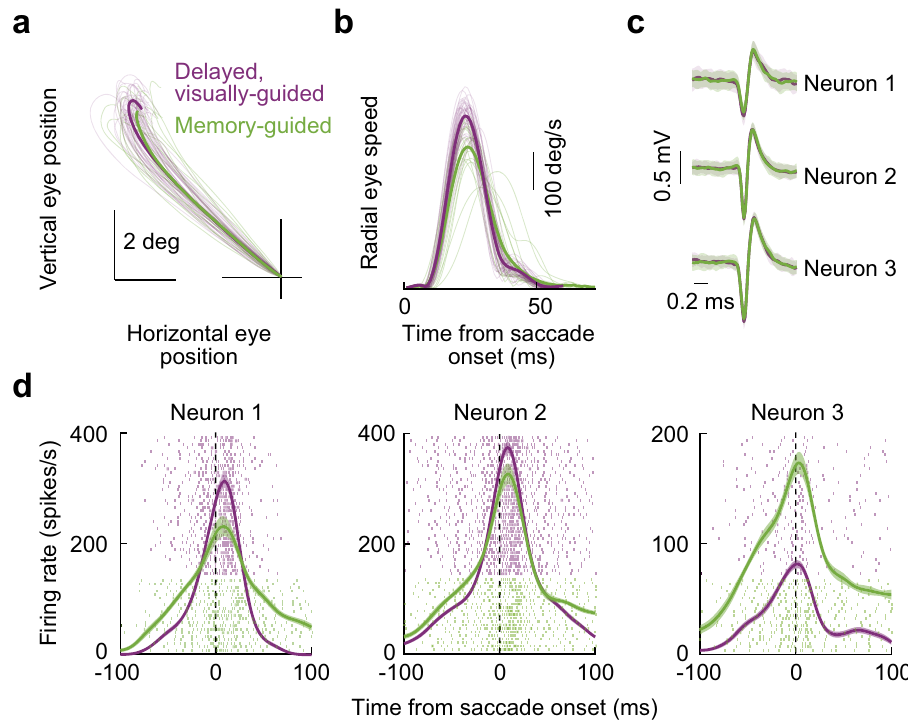
Fig. 6 Superior colliculus motor burst strength is dissociated from saccade kinematics even for vector-matched movements. a Example saccade trajectories from one session of the vector-matched experiments. Thin lines show individual movements, and thick lines show averages across trials. Purple denotes delayed, visually-guided saccades, and green denotes memory-guided saccades. The vectors of the two types of saccades were matched ( “ Methods ” ). b Memory-guided saccades were systematically slower than their visually-guided counterparts, as might be expected 24 – 30 . c Spike waveforms from 3 example neurons recorded simultaneously during the same session. Each thick line shows the average of a random sampling of waveforms from each of the two tasks. The error bars denote the s.d. across observations. In all cases, the waveforms were stable across the two task types, suggesting that each neuron was successfully recorded in the two tasks. The numbers of waveforms included in the averages for the visually-guided and memory-guided conditions, respectively, are: 70/97 (Neuron 1), 79/74 (Neuron 2), and 42/54 (Neuron 3). d The neurons of c had a large diversity